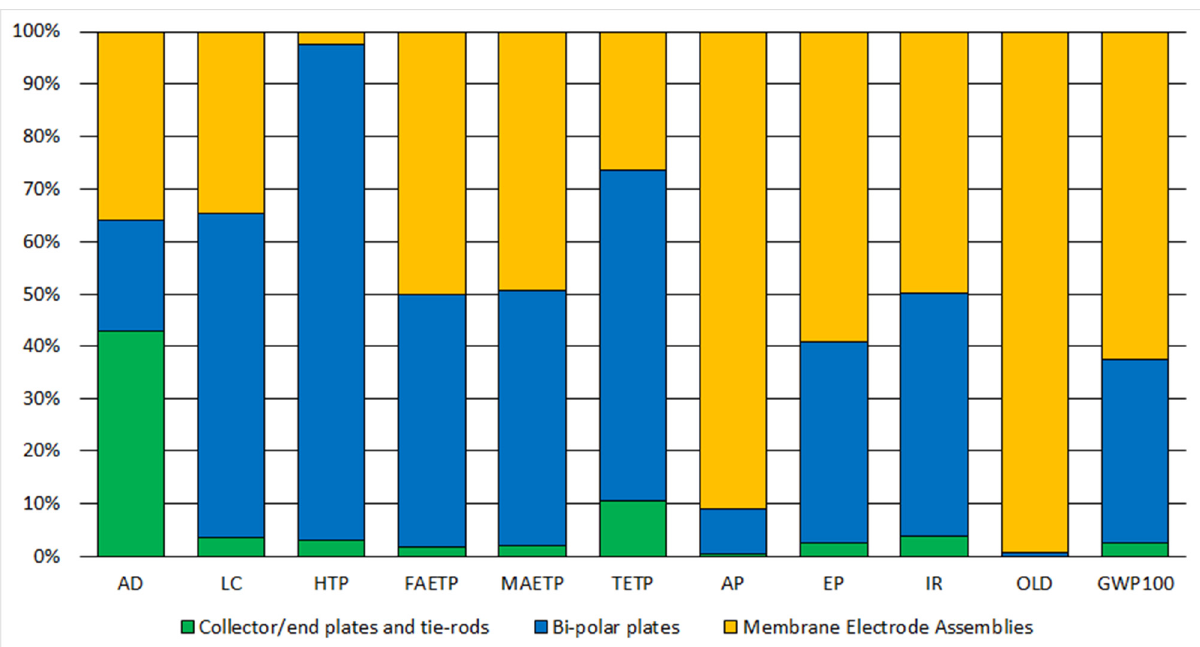
Figure 6. Impact of PEMFC components on the 11 impact categories. AD = Abiotic Depletion (elem., reverse base); LC = Land Competition; HTP = Human Toxicity Potential 100a; FAETP = Freshwater Aquatic Eco Toxicity Potential 100a; MAETP = Marine Aquatic Eco Toxicity Potential 100a; TETP = Terrestrial Eco Toxicity Potential 100a; AP = Acidification Potential (fate not incl.); EP = Eutrophication Potential (incl. fate); IR = Ionising Radiation; OLD = Ozone Layer Depletion (including NMVOC average); GWP = Global Warming Potential 100a (incl. NMVOC av.).